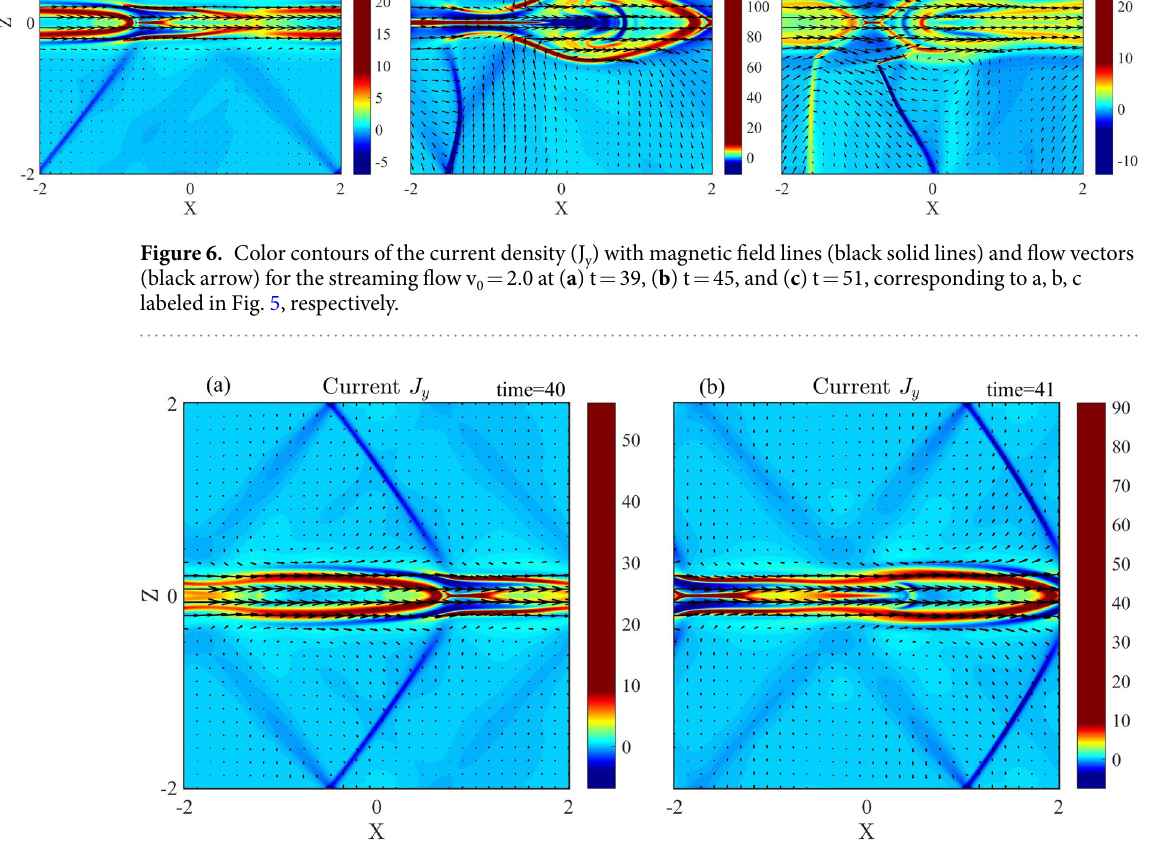
Figure 7. Color contours of the current density (J y ) with magnetic field lines (black solid lines) and flow vectors (black arrow) at the times: ( a ) t = 40 and ( b ) t = 41.